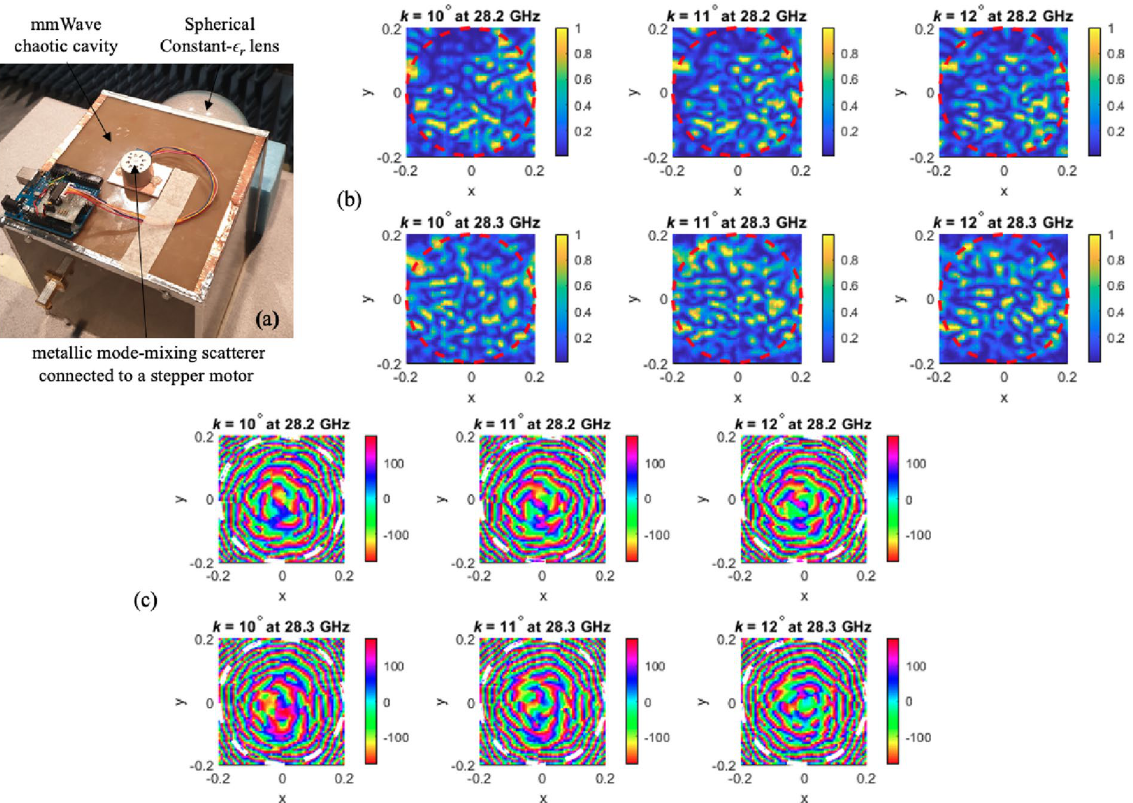
Figure 10. ( a ) Stepper motor connected to the lens-loaded cavity. Measured y -components of E -field in terms of ( b ) normalized magnitude (V/m) and ( c ) phase (degree) contour plots.